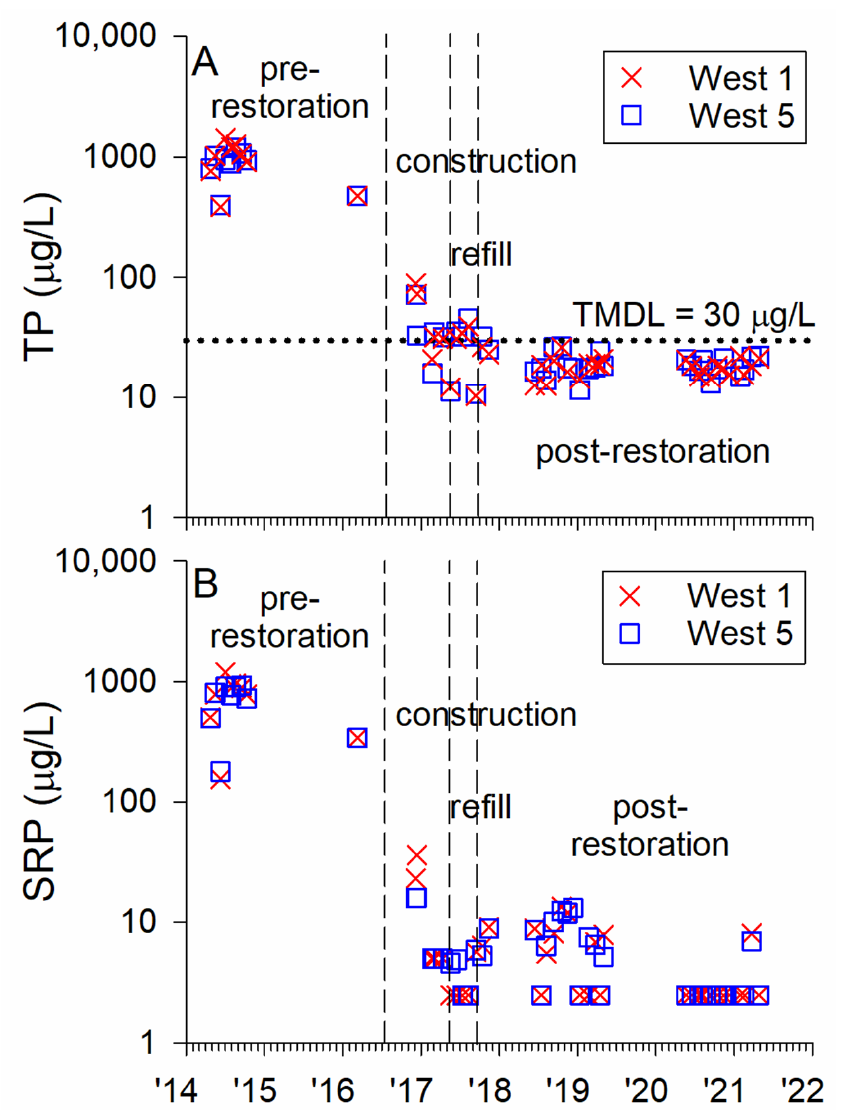
Figure 3. West pond TP ( A ) and SRP ( B ) site concentrations over 2014–2021 monitoring period, divided into restoration phases. Reference line at 30 μg/L represents TP target goal set by the Bear Lake TMDL [26]. Note the log scale y -axis.